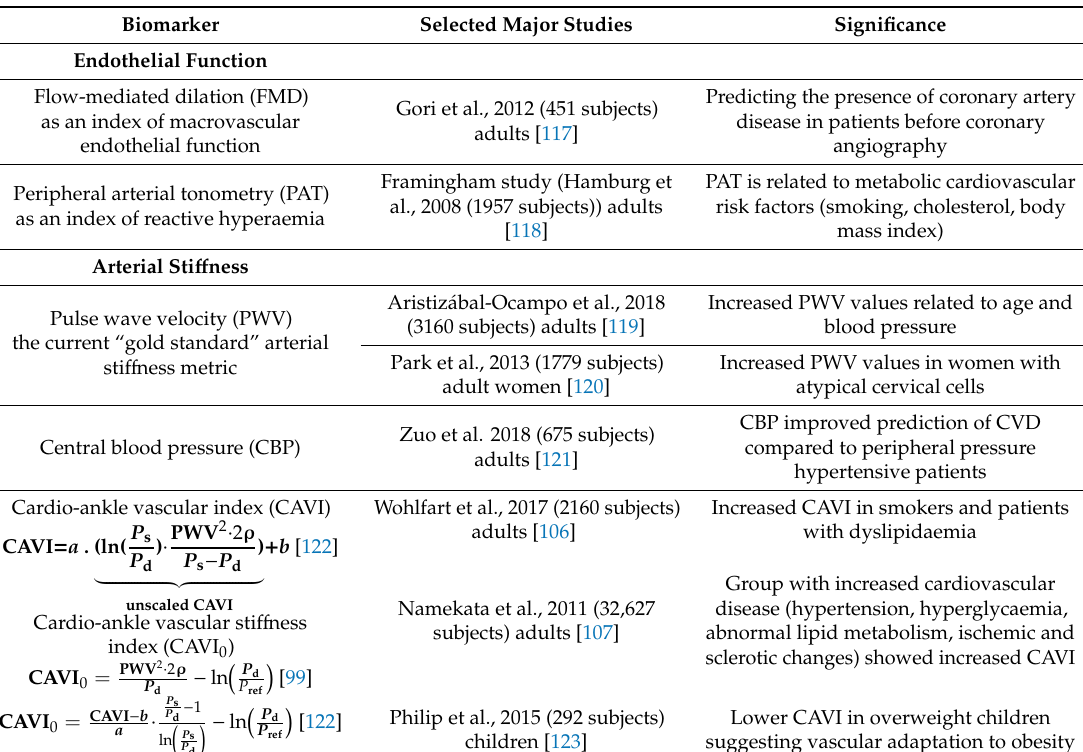
Table 1. Biomarkers for early atherosclerotic